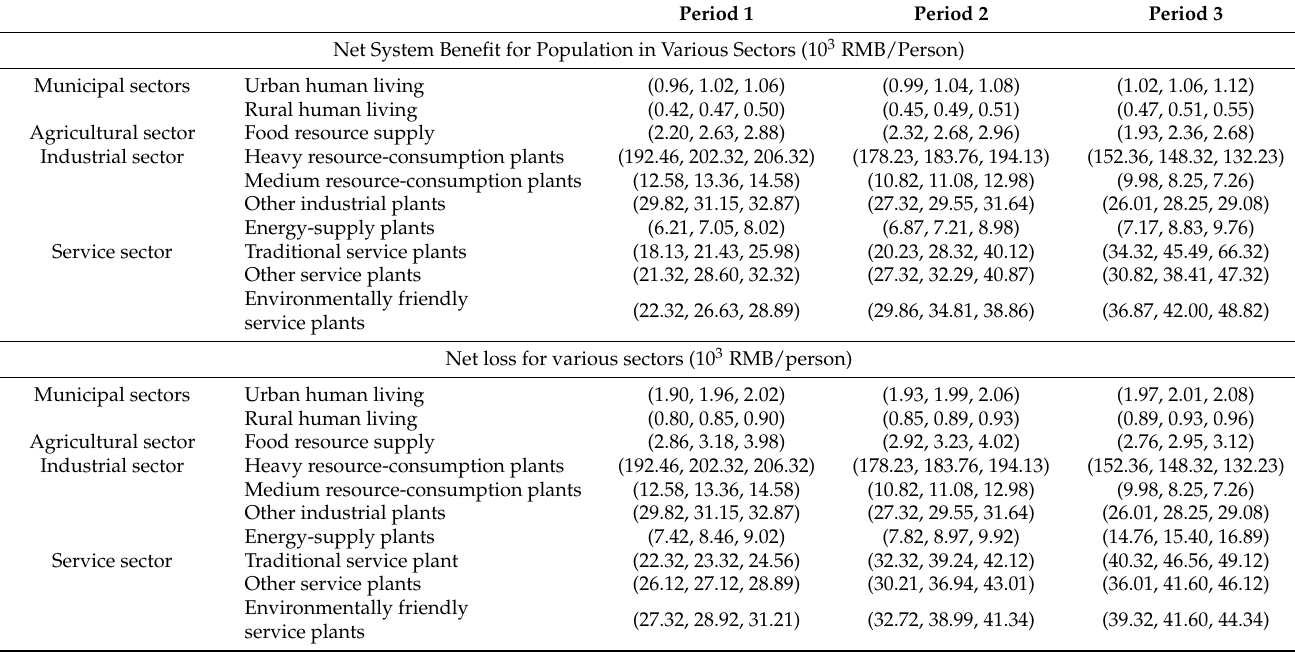
Table 4. Economic